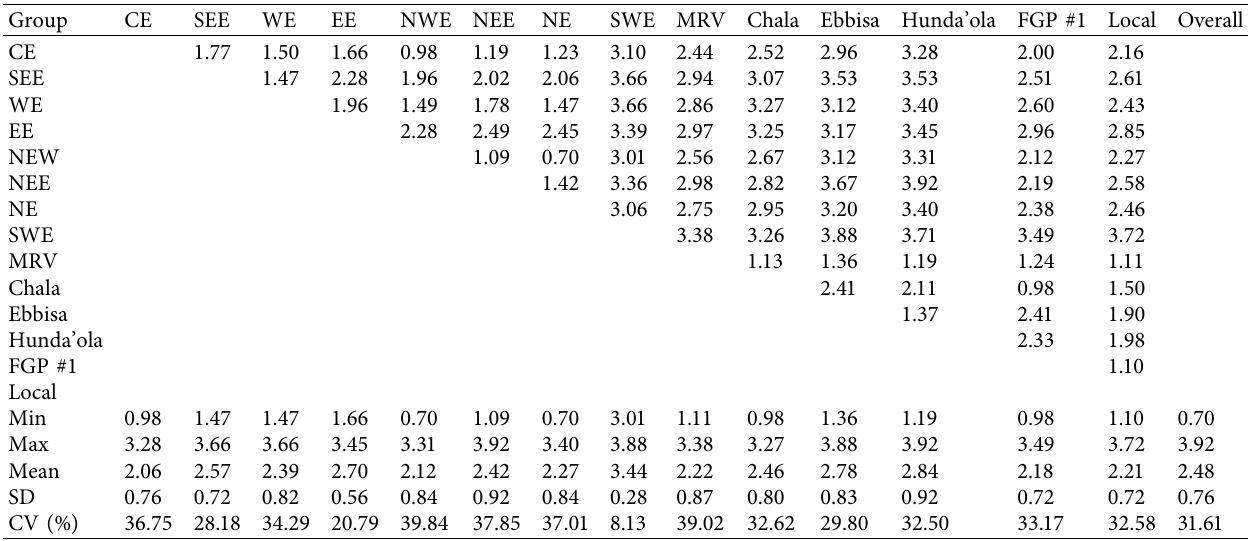
Table 7: Dendrogram generated based on the UPGMA clustering method depicting relationships among accessions of eight geographic regions and fve checks based on groups mean values for 11 agromorphological traits.